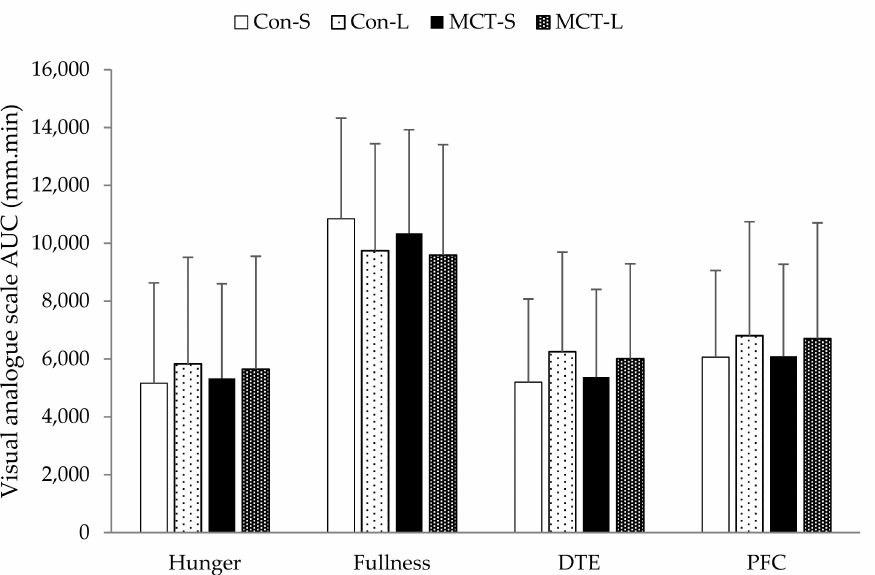
Figure 2. Area under the curve values for hunger, fullness, desire to eat (DTE) and prospective food consumption (PFC) following breakfasts in all trials. Data are expressed as means and vertical bars indicate standard